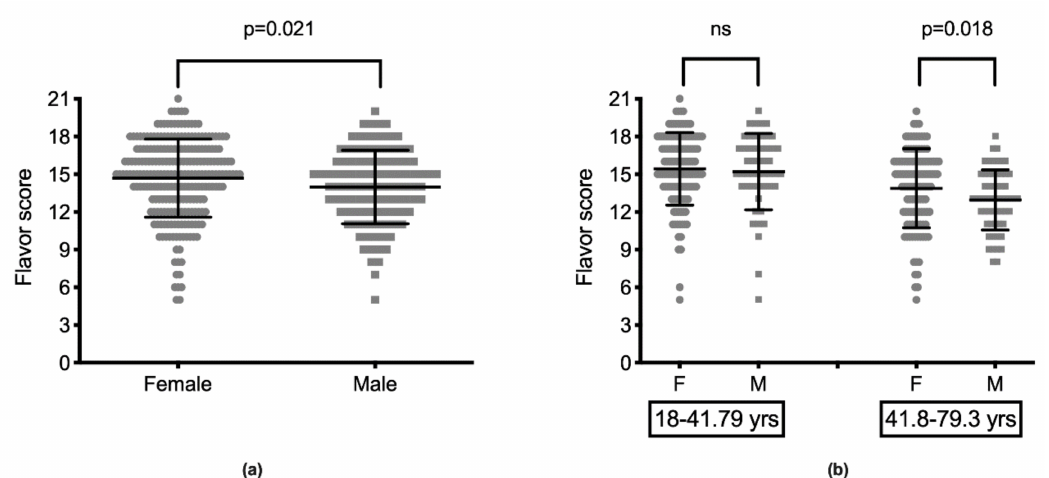
Figure 2. Sex di ff erences in flavor recognition. Mean + SD of flavor score (FS) ( a ). Females (dots, n = 241) had significantly higher FSs than males (squares, n = 107). When the studied population was split into two groups according to the median age (41.79 years) ( b ), no di ff erences between females (n = 127) and males (n = 49) were present in younger subjects, while FSs were significantly higher in females (n = 114) than in males (n = 58) in older subjects.